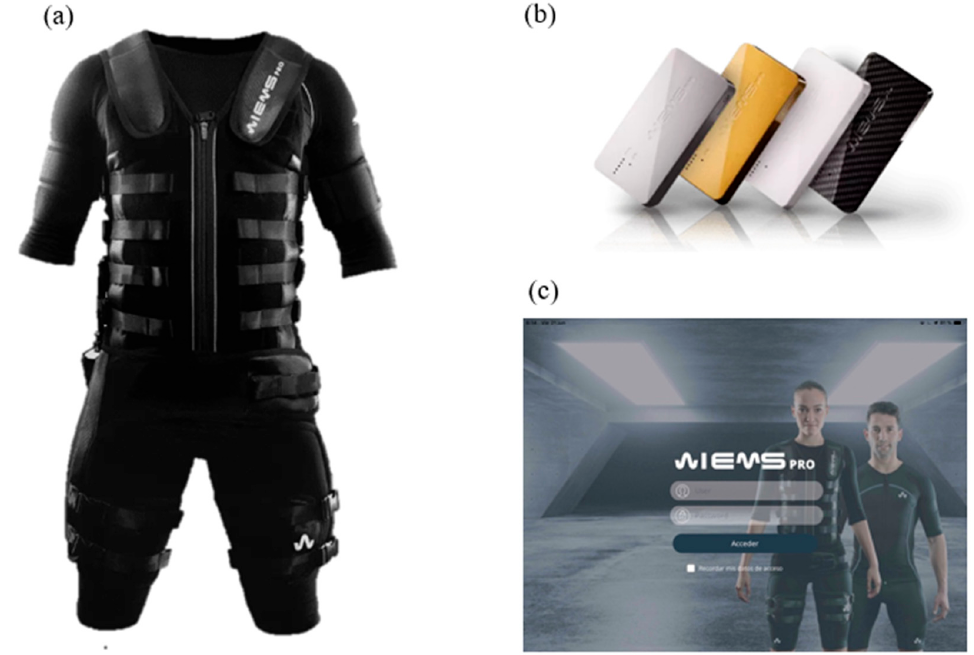
Figure 2. ( a ) Whole-body electromyostimulation suit; ( b ) whole-body electromyostimulation devices that transmit electrical stimuli; ( c ) whole-body electromyostimulation app to configure electrical stimuli.